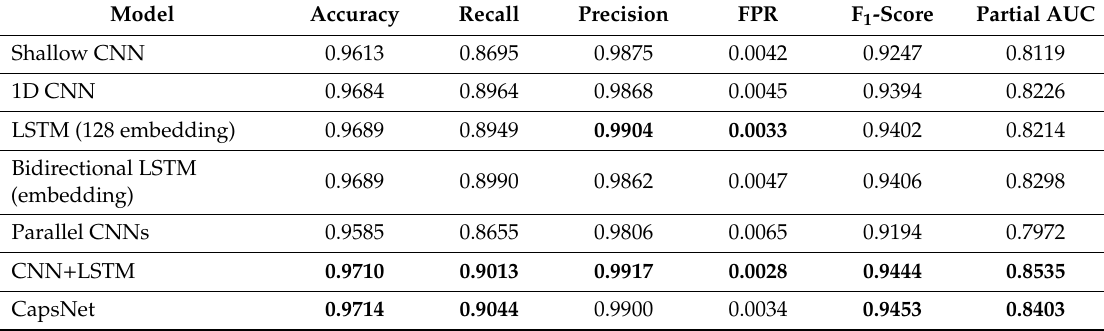
Table 4. Results of the novel domain generation algorithm (DGA) experiment with the test